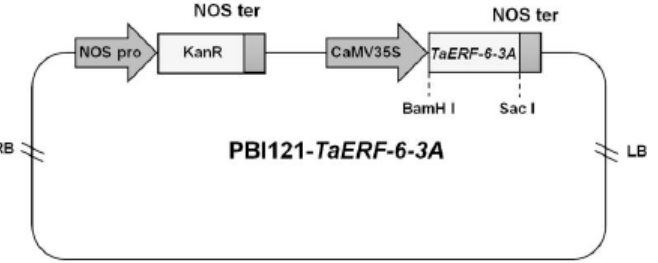
Figure 9. Schematic diagram of plant overexpression vector pBI121. LB, left border; RB, right border. NOS pro, nopaline synthase gene promoter; NOS ter, nopaline synthase gene terminator; CaMV 35S, CaMV 35S promoter; KanR, kanamycin resistance; BamH I and Sac I, enzyme-digested sites.